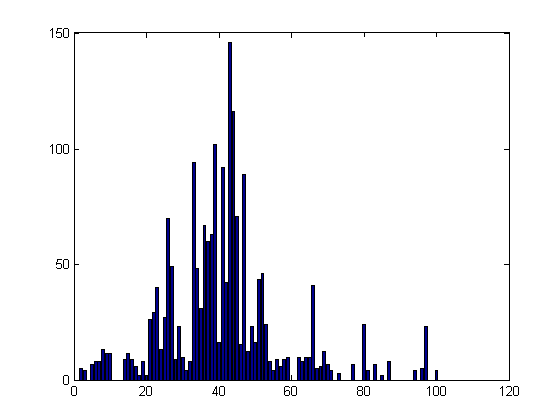
Figure 7. The “unmixing histogram” for Figure 3. The x -axis is the b partition of [0 , 1] , ε = 0 . 01 . The y -axis is the number of coordinates that belongs to each interval in the b partition